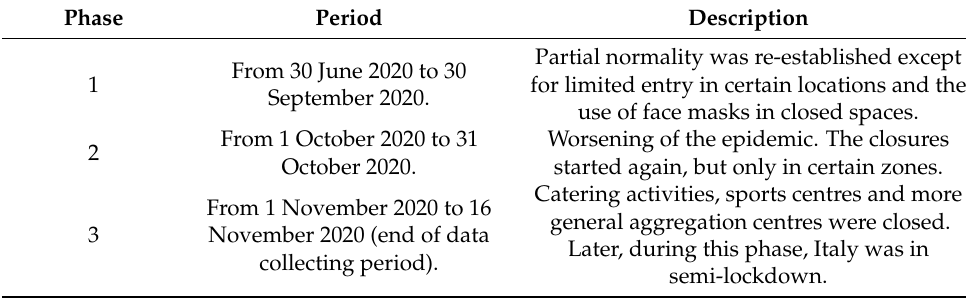
Table 2. Phases and descriptions during COVID-19 pandemic in Italy.